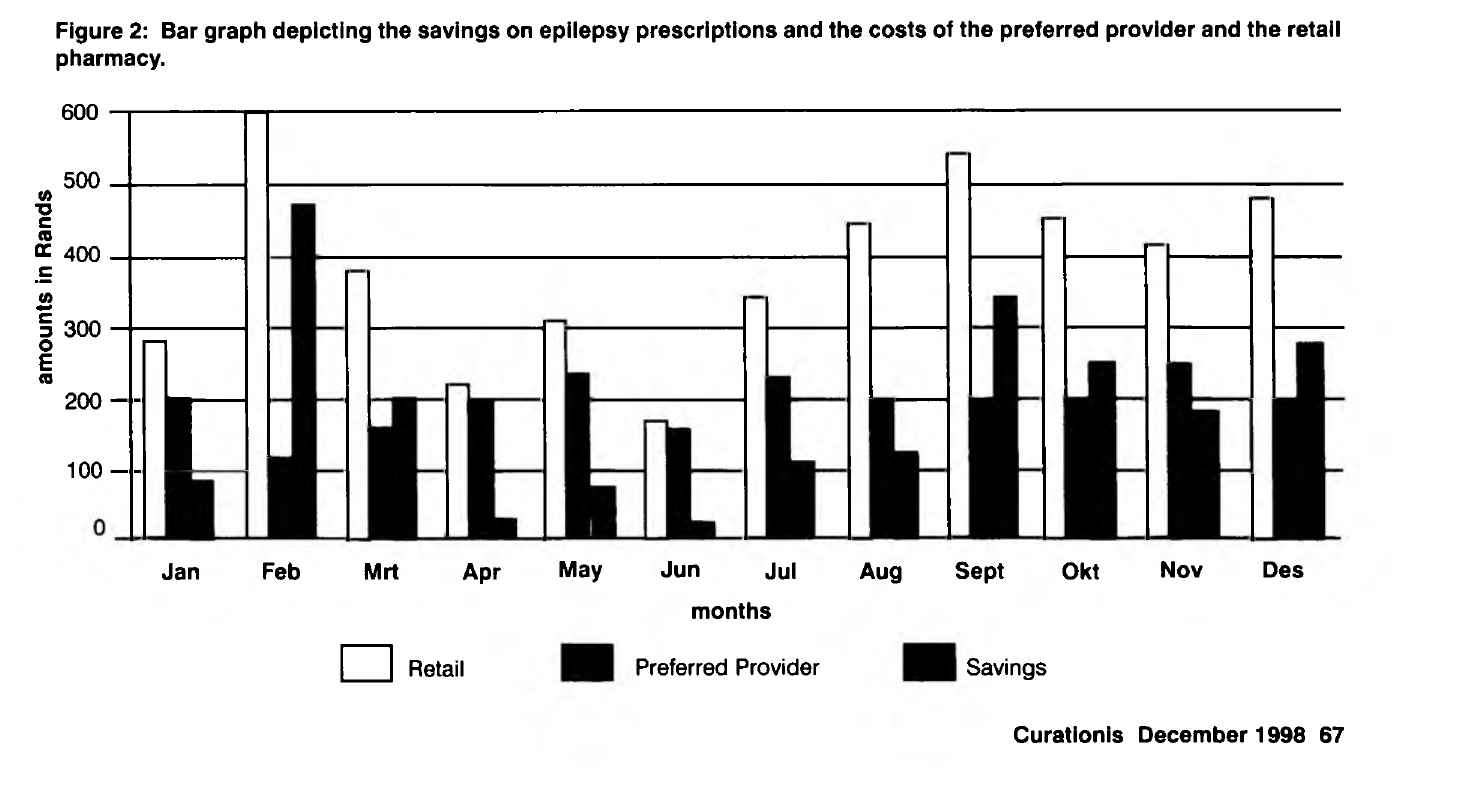
Figure 2: Bar graph depicting the savings on epilepsy prescriptions and the costs of the preferred provider and the retail